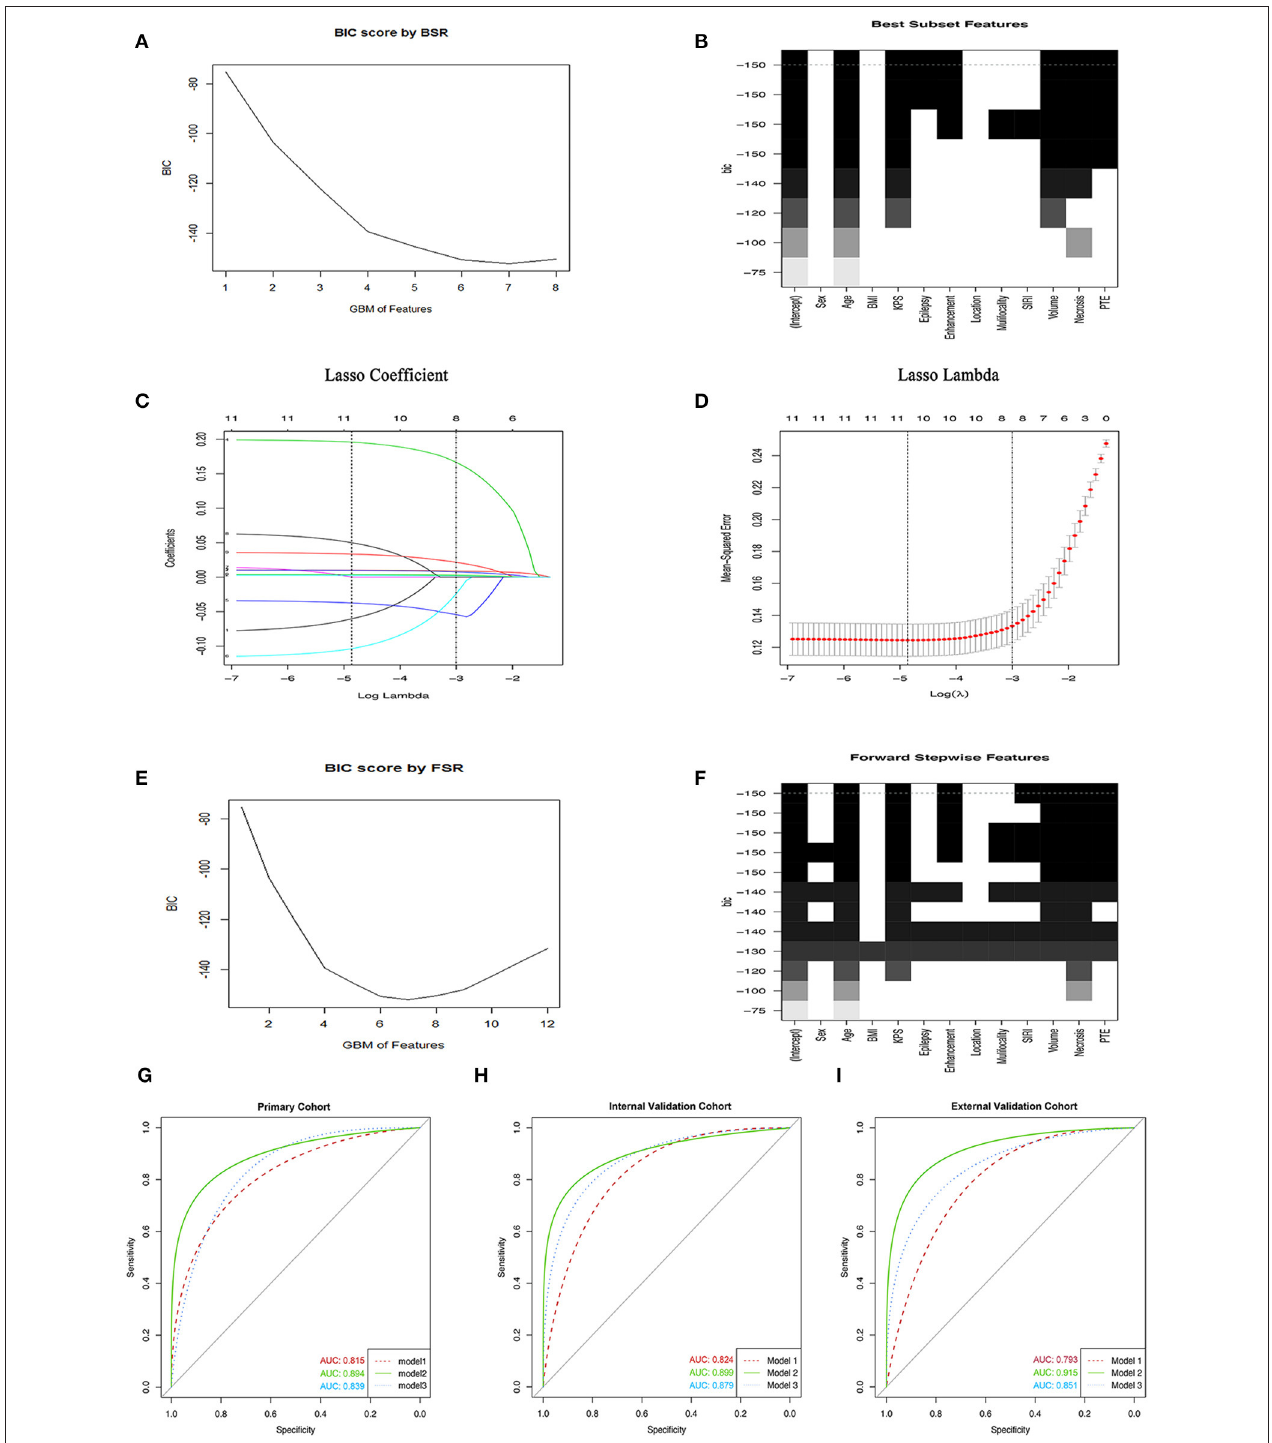
FIGURE 1 | Variables selection methods. (A,B) The selection of variables using the BSR method. (C) The LASSO coefficient profile of 12 GBM-related variables in primary cohort. (D) 10-fold cross-validation (CV) for tuning parameter ( λ ) selection. (E,F) The FSR method was used to select variables. (G–I) The ROC curves of GBM in primary cohort and two validation cohorts, respectively. BIC, Bayesian information criterion; GBM, glioblastoma multiforme; BSR, best subsets regression; FSR, forward stepwise regression; BMI, body mass index; SIRI, systemic inflammation response index; pEO, preoperative epilepsy occurrence; pKPS, preoperative Karnofsky performance status; PTE, peritumoral